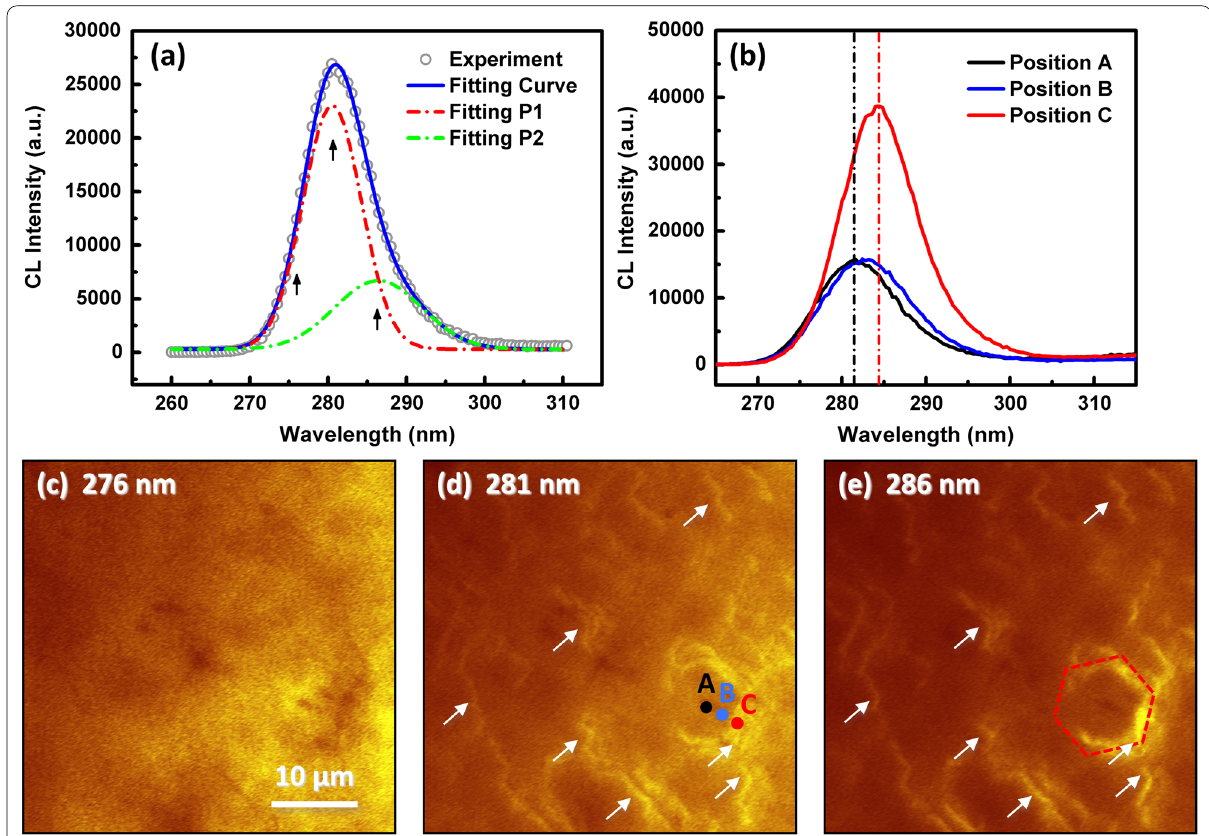
Fig. 2 a Experimental and Gaussian-fitted CL spectra of MQWs. Black arrows indicate the wavelength used for the mapping. b CL spectra collected in Position A, B and C, and monochromatic CL mapping images taken in the same area at 285 K using the wavelengths of c 276 nm, d 281 nm